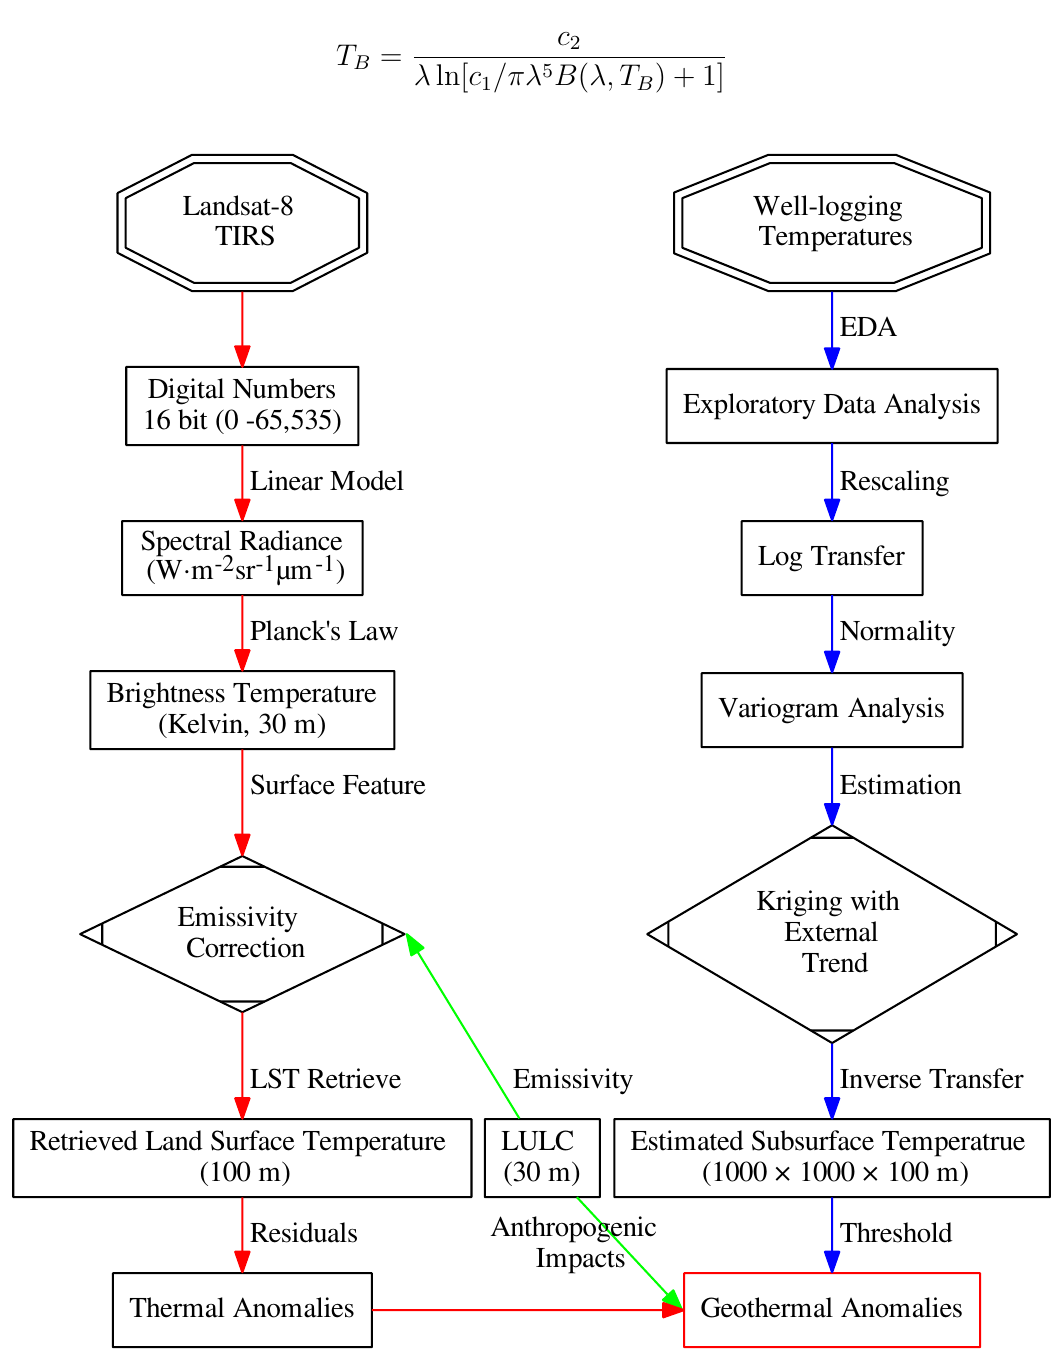
Figure 7. Workflows of subsurface and surface temperature modeling to detect high temperature anomaly zones based on a combination of the well-logging temperatures database and satellite Thermal InfraRed Sensor (TIRS)